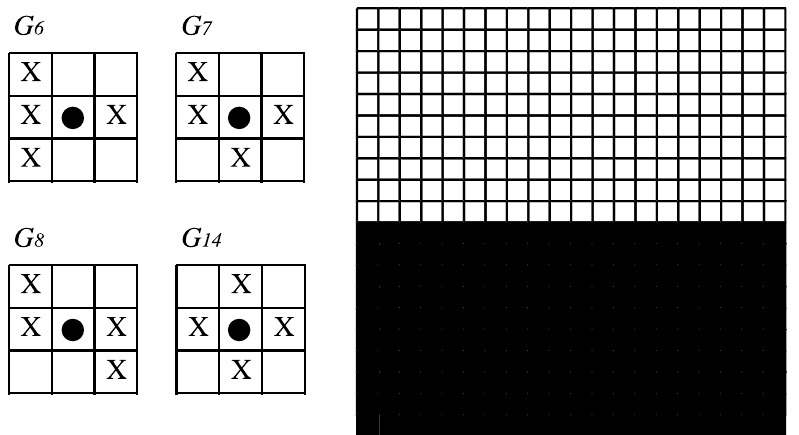
Figure 8. Upper/right border configuration: spurious fixed point for grids G 6 , G 7 , G 8 and G 14 . State + 1 is represented by color black and − 1 is represented by color white.